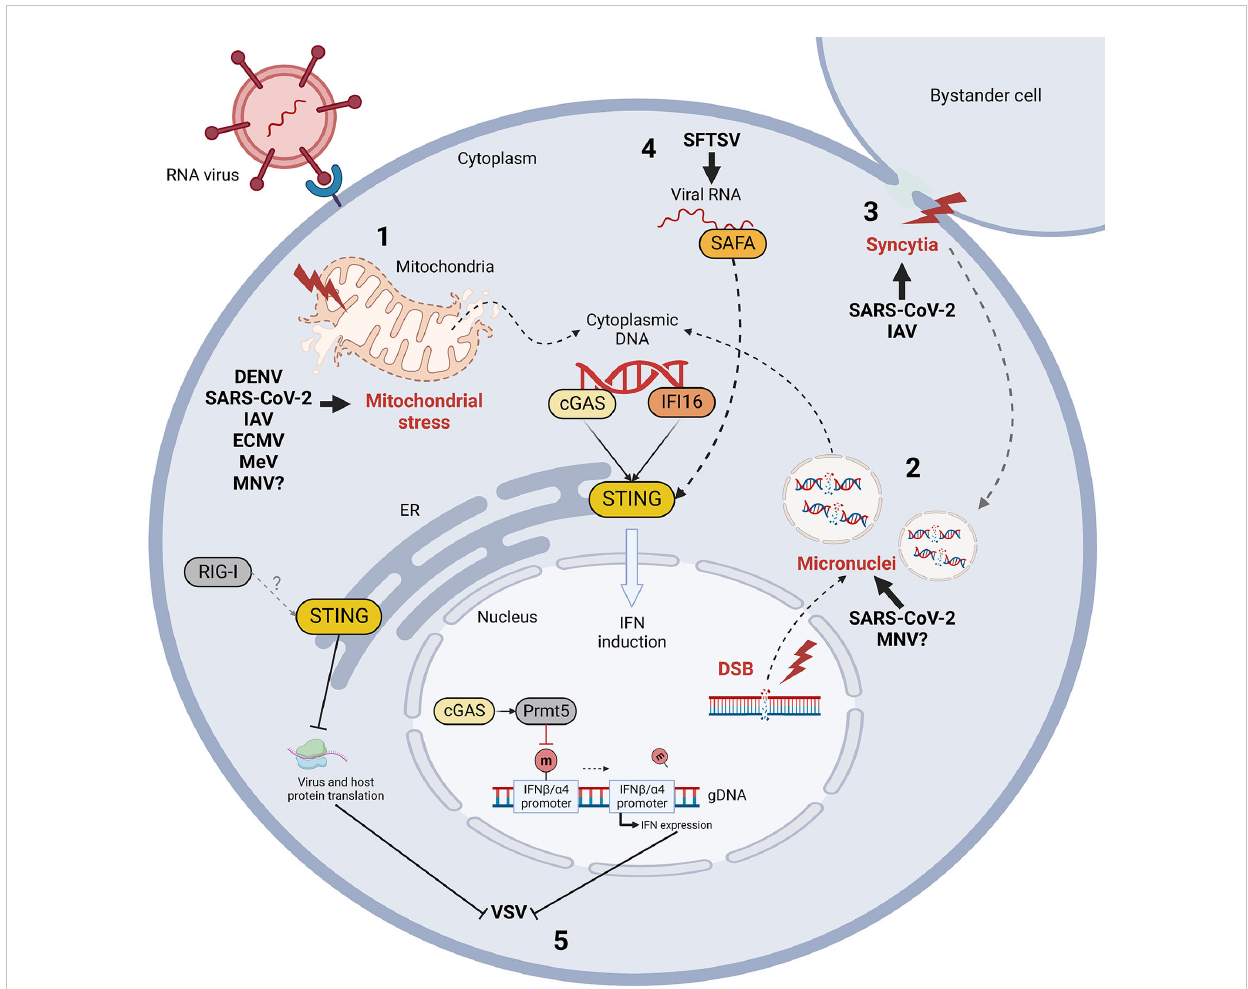
FIGURE 3 Mechanism of indirect cGAS/STING activation by RNA virus infection and STING-mediated control of RNA viral evasion. RNA virus infections trigger the release of self dsDNA in the cytoplasm due to mitochondrial stress (1) and/or genomic DNA damage and micronuclei formation (2) (red). Double strand breaks (DSB) and micronuclei can also be induced by virus-induced cell-to-cell fusion (syncytia formation, in red) (3). Cytoplasmic DNA is then detected by cGAS and IFI16 sensors leading to STING activation. Moreover, STING can be activated non-canonically by nuclear matrix protein scaffold attachment factor A (SAFA) through the mediation of viral RNA during Bunyaviridae infections (4). Finally, while IFN induction is considered the major STING-dependent anti-viral mechanism, STING and cGAS can also limit vesicular stomatitis virus (VSV) infection by inhibiting protein translation and by enhancing IFN expression through Prmt5 activation, respectively (5). DENV, Dengue virus; SARS-CoV-2, severe acute respiratory syndrome coronavirus 2; IAV, in fl uenza A virus; ECMV, encephalomyocarditis virus; MeV, measles virus; MNV, murine norovirus; SFTSV, severe fever with thrombocytopenia syndrome virus; m, methyl